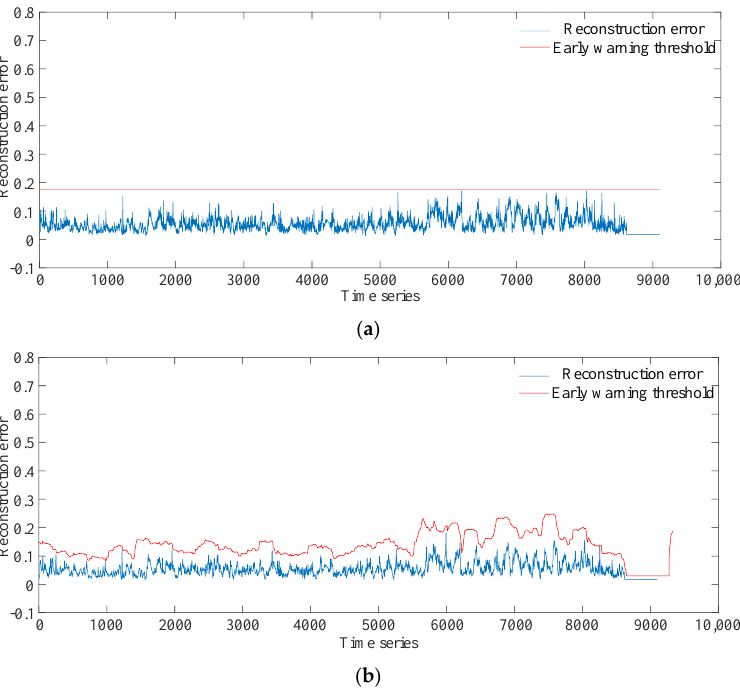
Figure 7. Training set reconstruction error. ( a ) Fixed threshold. ( b ) Adaptive threshold based on sliding window.